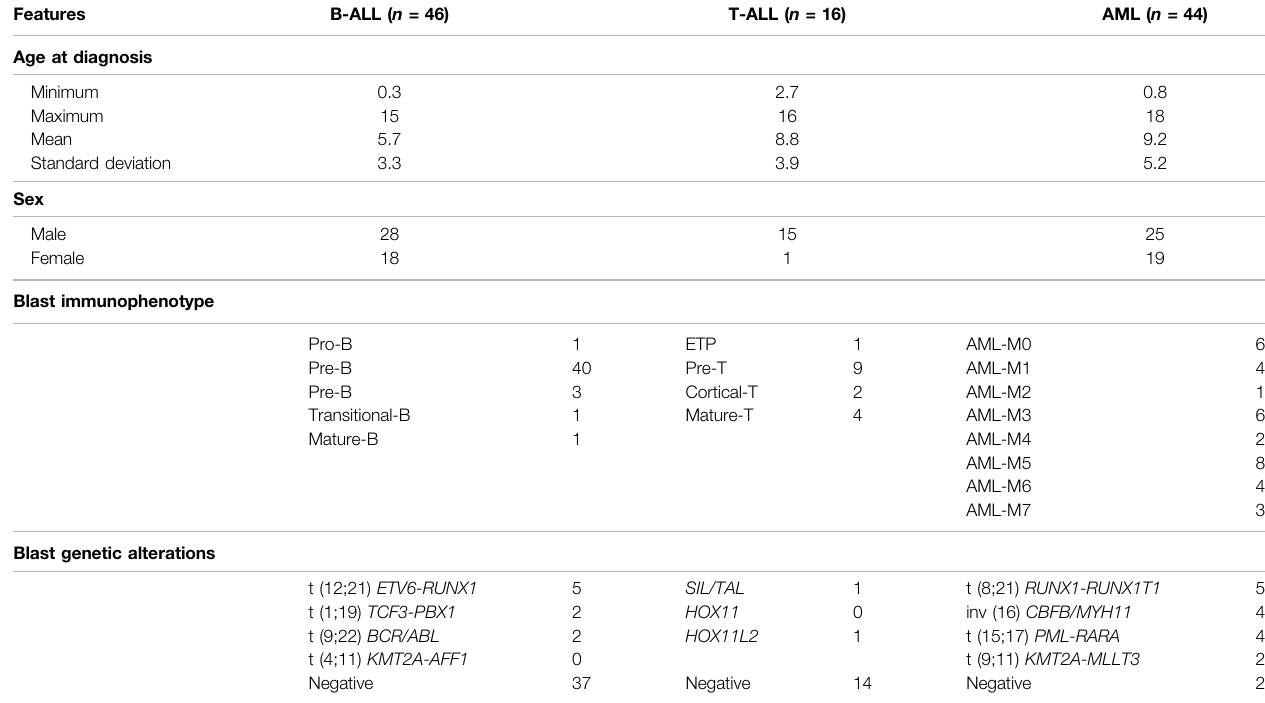
TABLE 1 | Characterization of childhood acute leukemia patients.